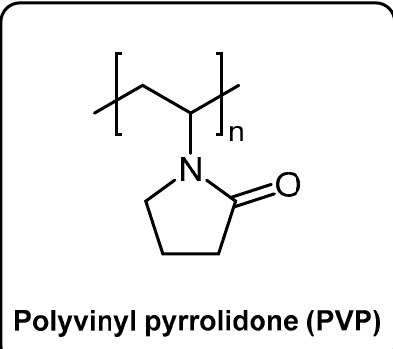
Figure 1. The chemical structure of PVP.